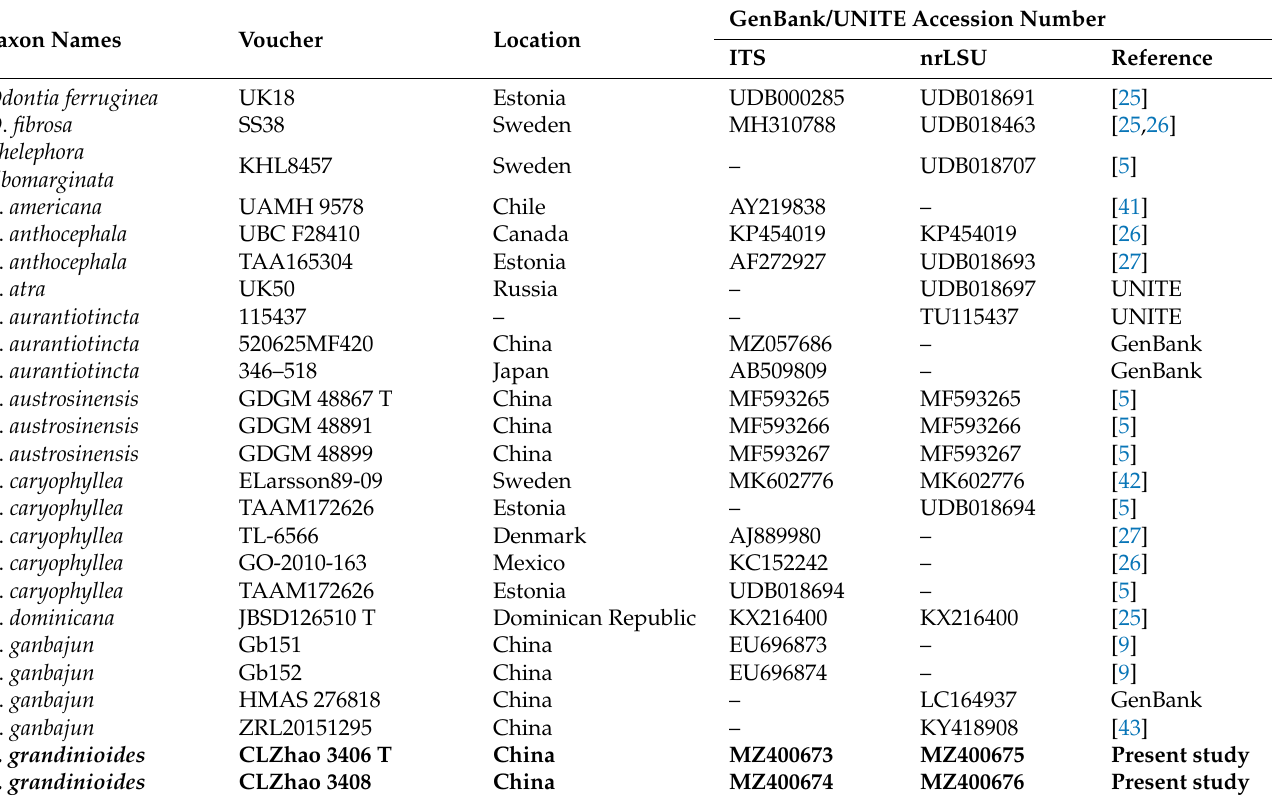
Table 1. Names, vouchers, location, and corresponding GenBank/UNITE accession numbers of taxa used in this study. The newly generated sequences are shown in black bold and T indicates the